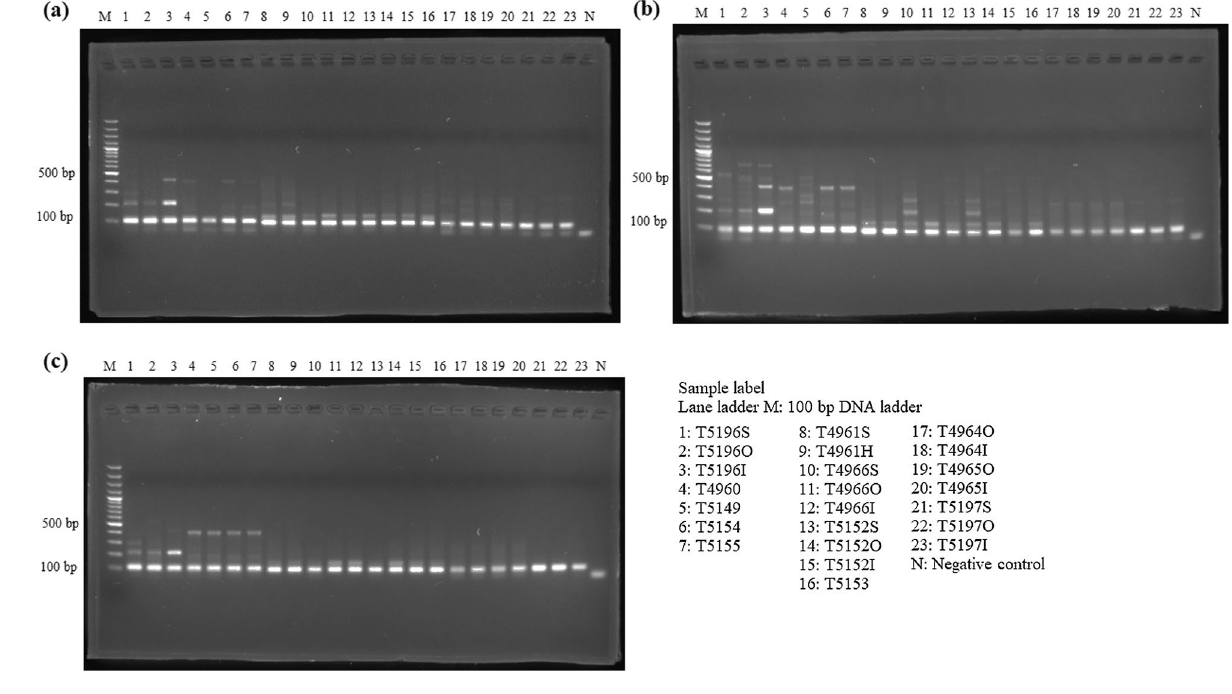
Figure 1. Gel electrophoresis of PCR amplification results of all authentic wood samples using different extraction methods, ( a ) SDS-based method, ( b ) QIAGEN method, and ( c ) CCDB method, with internal control primer set trnL gh.